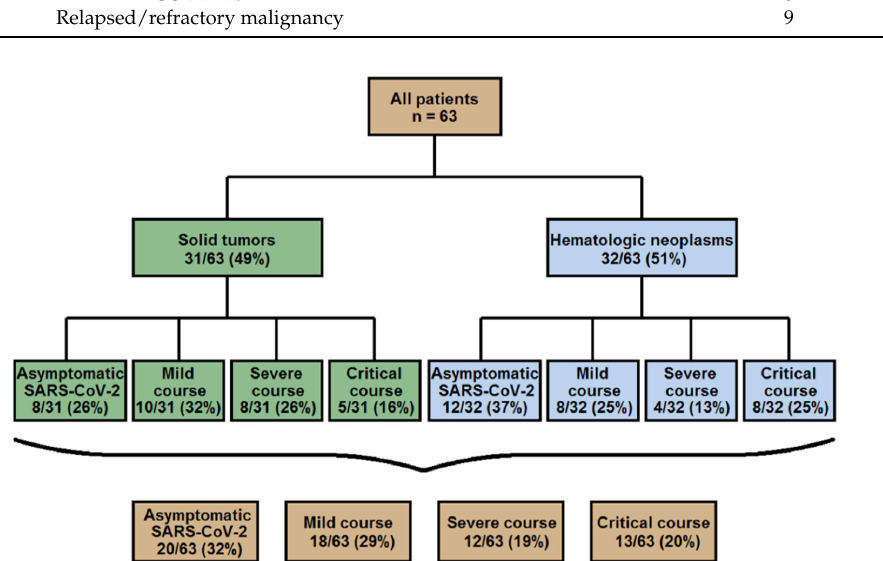
Figure 1. Indication for SARS-CoV-2 testing.